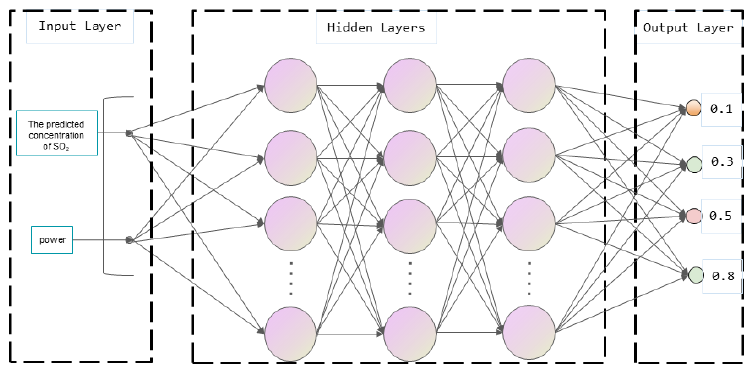
Figure 2. The schematic diagram of the sulfur content prediction model.